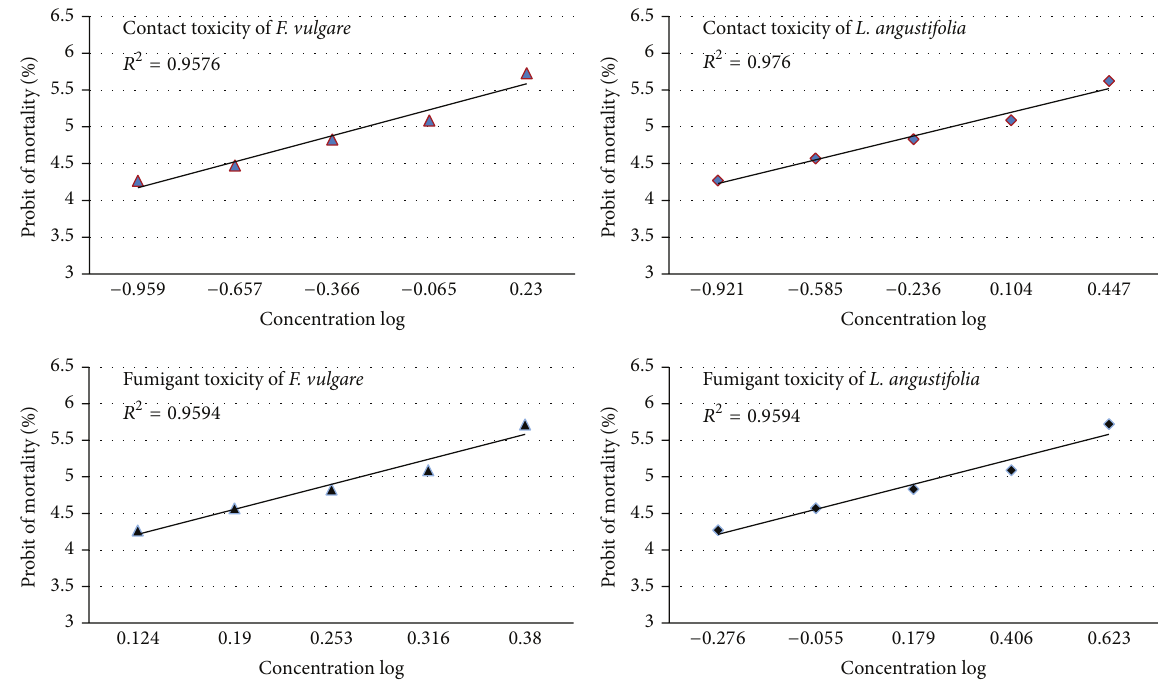
Figure 1: Concentration-mortality response lines for adult females of Tetranychus urticae exposed to different concentrations of Foeniculum vulgare and Lavandula angustifolia essential